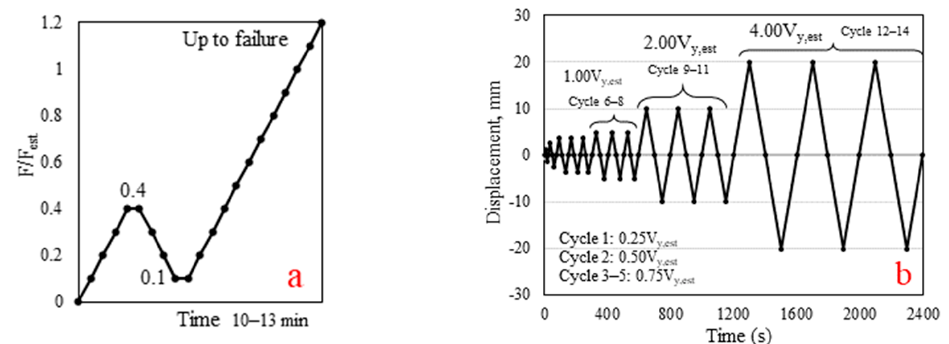
Figure 5. Horizontal in-plane loading protocol for ( a ) monotonic; ( b ) cyclic loading.